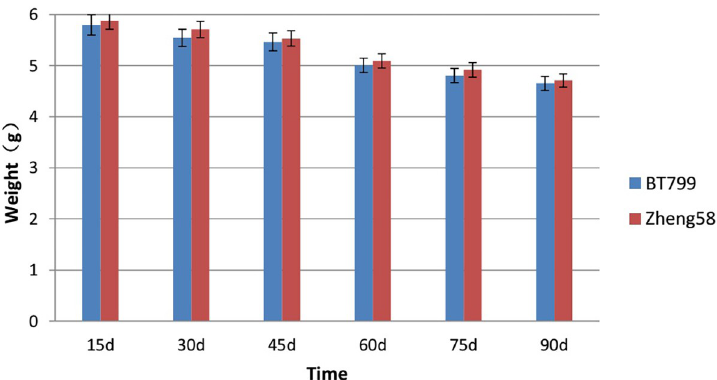
Fig 2. Effects of Bt maize on the weight of E . fetida , from six investigations. Values are means ± SE, n = 5.